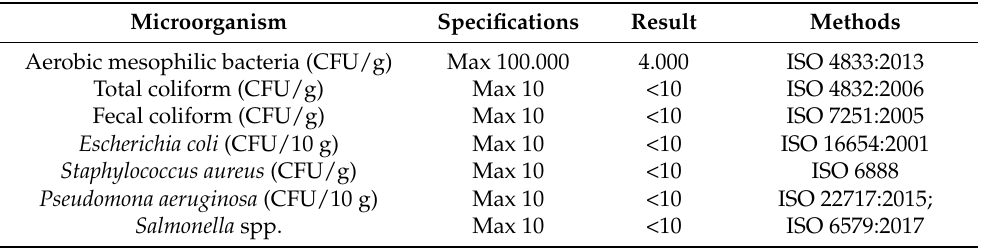
Table 4. Microbiological results of the obtained formulation estimated according to ISO recommended